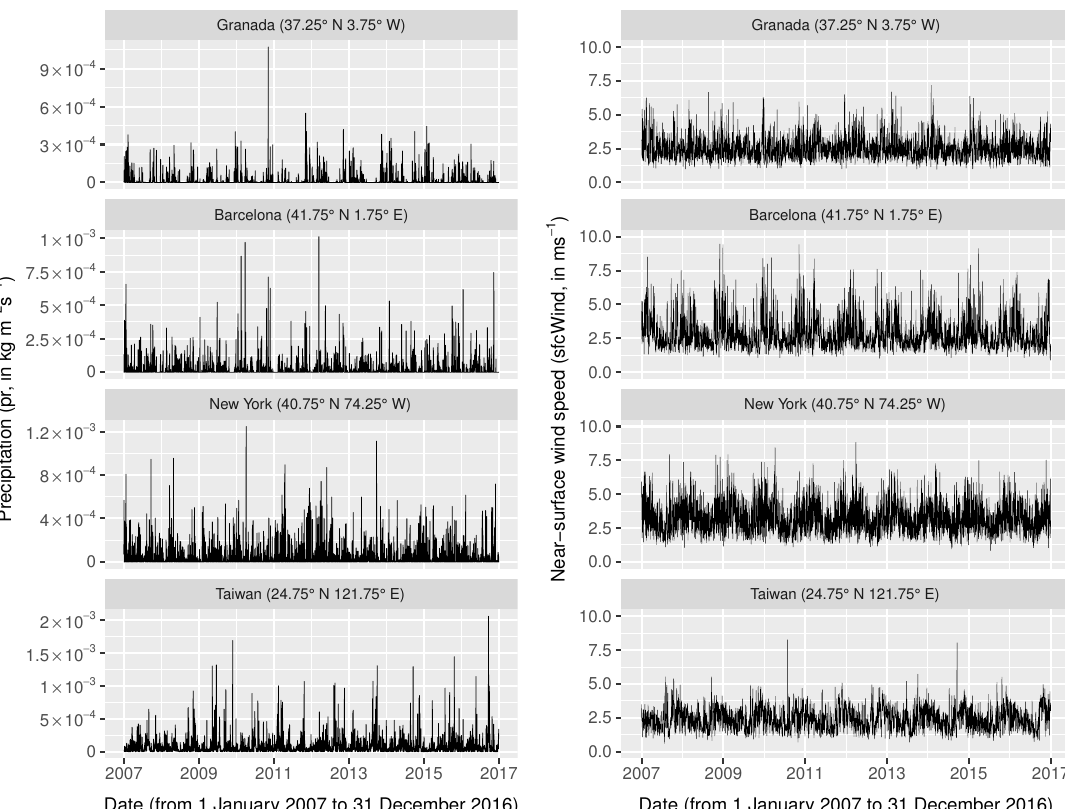
Figure 3. Daily time series of precipitation ( pr ) and near-surface wind speed ( sfcWind ) over four selected grid points (see Table 1), using EWEMBI data, from 1 January 2007 to 31 December